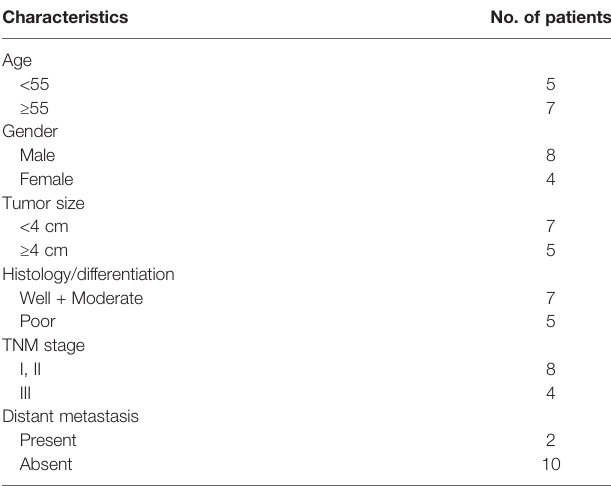
TABLE 1 | Clinicopathological characteristics of 12 CRC patients.